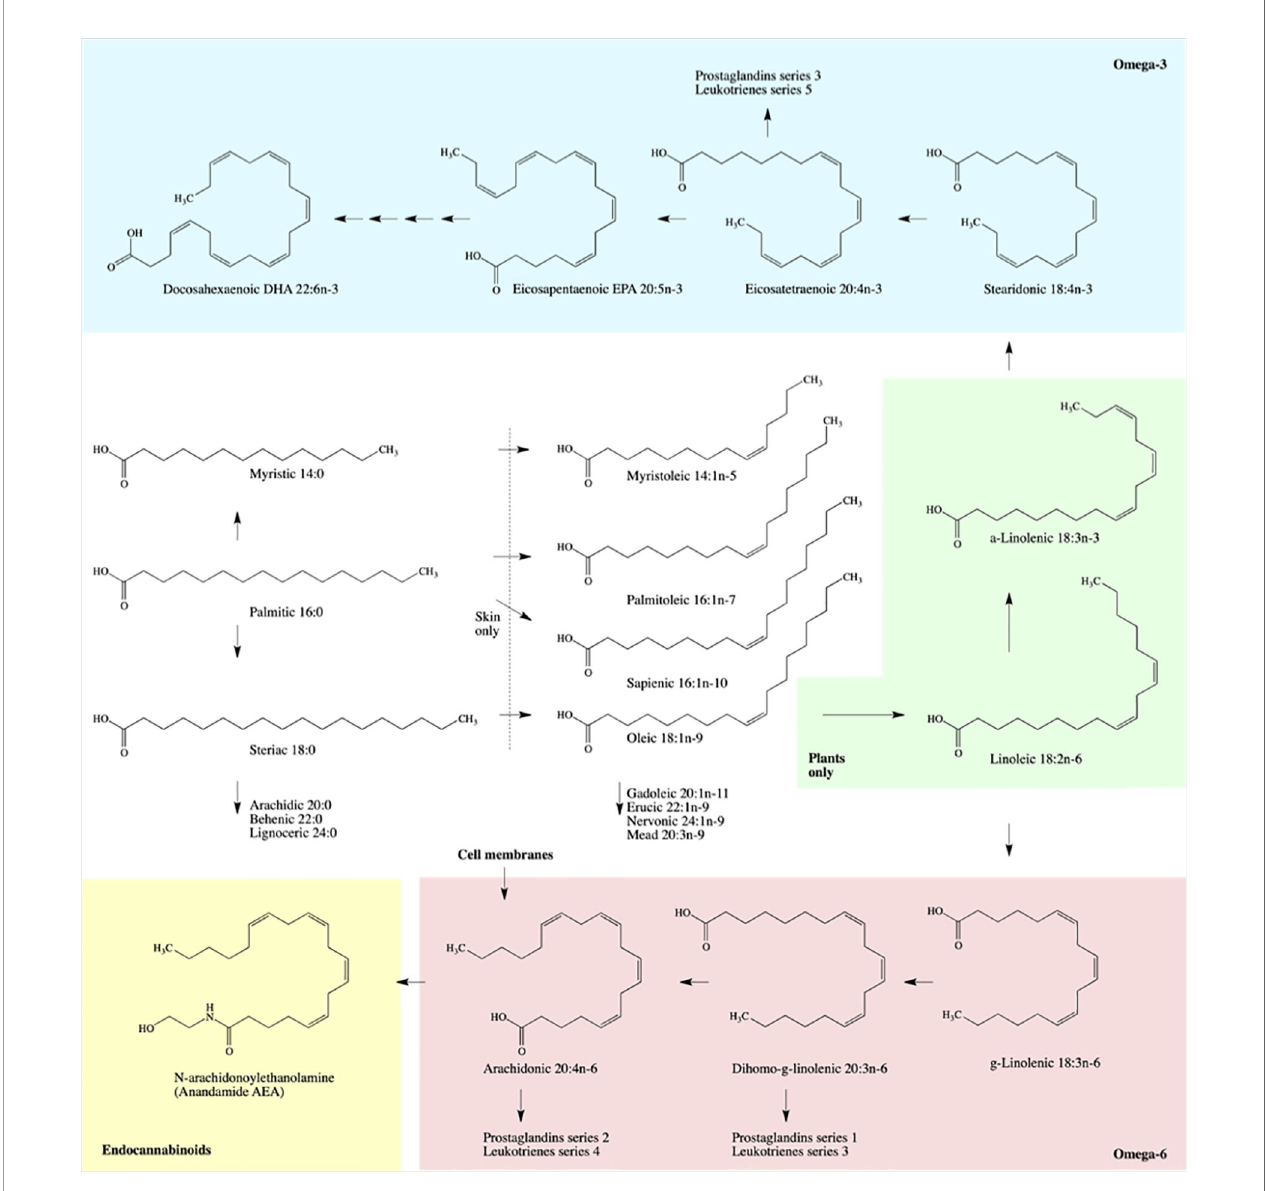
FIGURE 1 | Schematic biosynthesis pathways of fatty acid